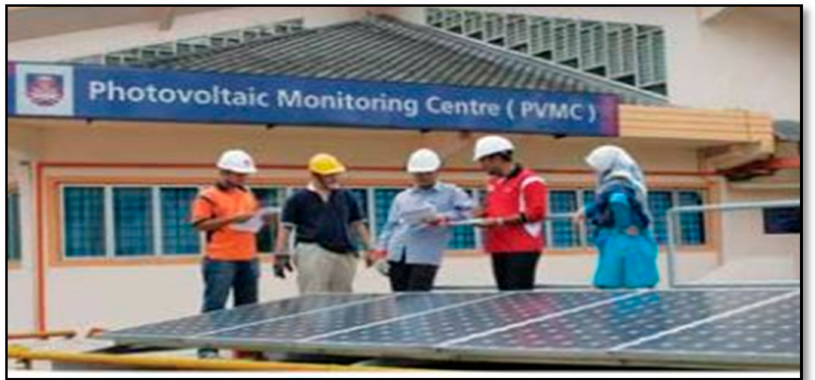
Figure 2. Training institutions at Universiti Teknologi MARA (UiTM), Malaysia